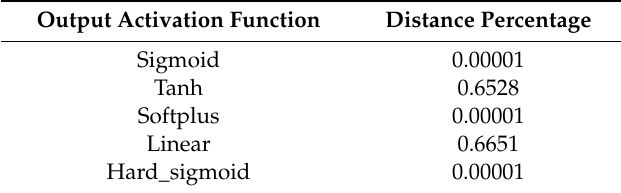
Table 5. The distance percentage of di ff erent output activation functions.